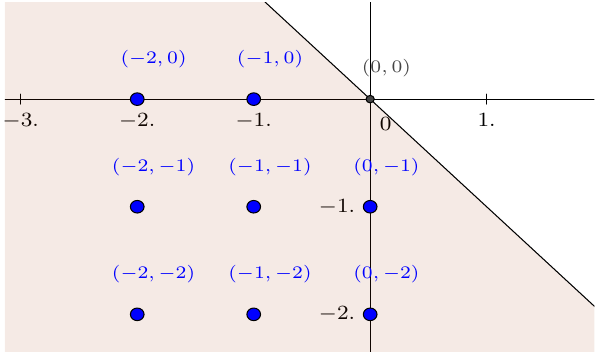
Figure 2. Maximal neighborhoods: Initial (maximal) candidate neighborhoods V 1 ≡ V 2 given as a collection of points ( i , j ) ∈ { ( 1,0 ) ; ( 1,1 ) ; ( 0,1 ) ; ( 1,2 ) ; ( 2,1 ) ; ( 2,2 ) ; ( 0,2 ) ; ( 2,0 ) }